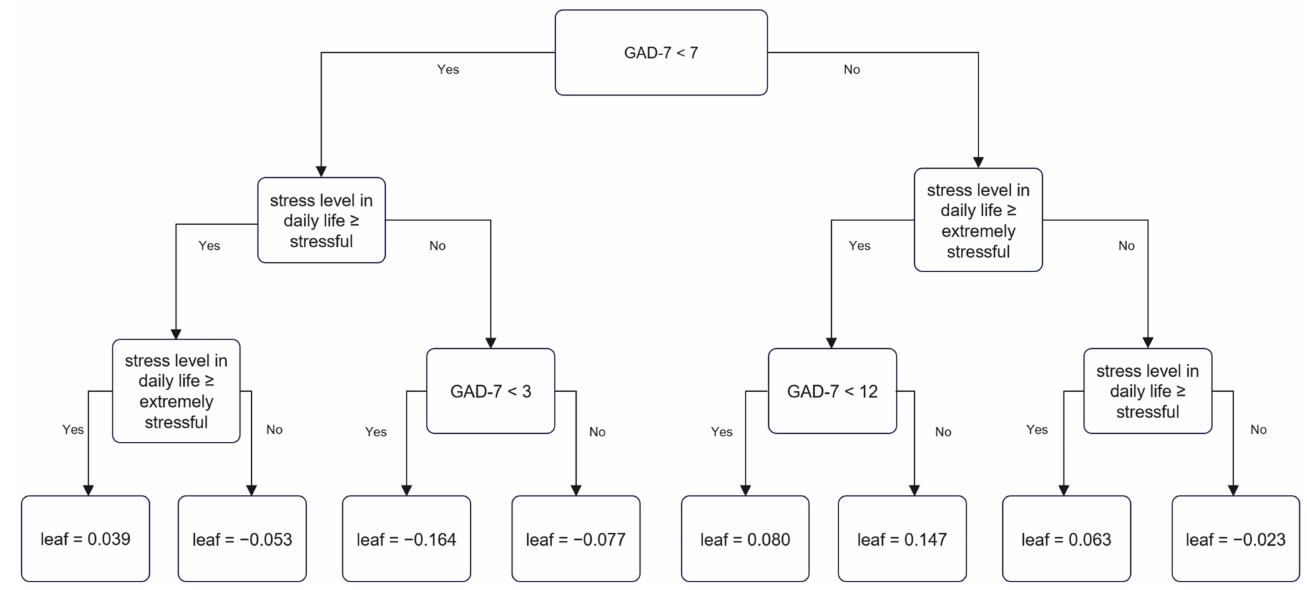
Figure 3. Decision tree of suicidal ideation in the low socioeconomic status group by XGBoost.